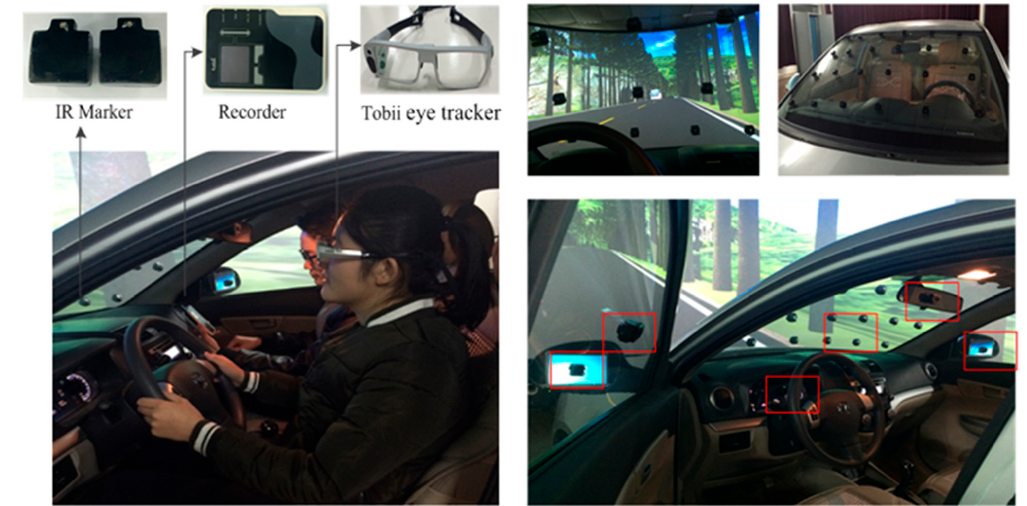
Figure 6. The IR-Marker distribution.